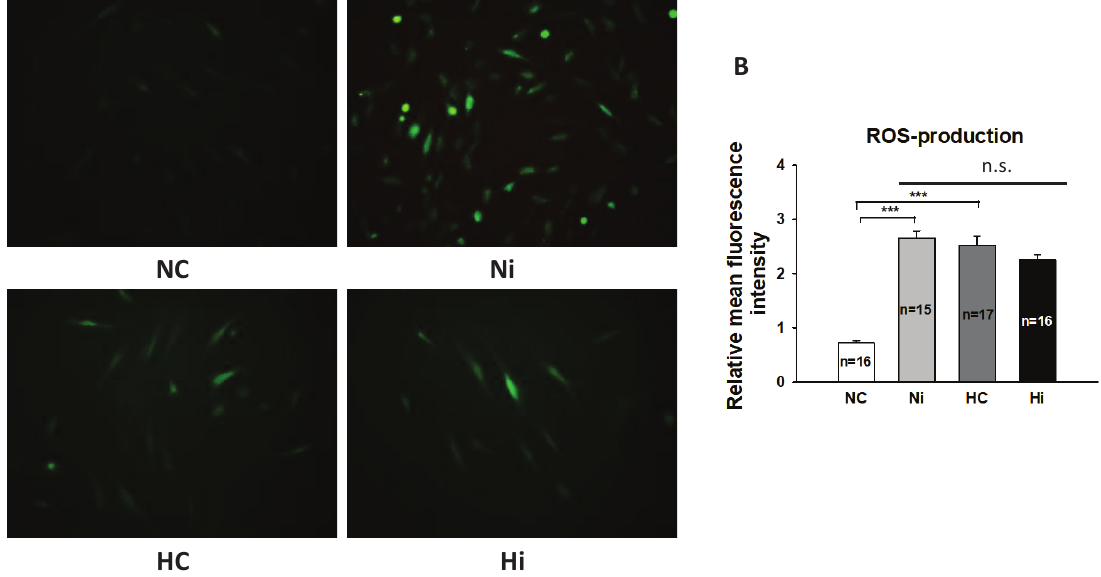
Figure 4. High-concentration isoprenaline and a high level of glucose induced ROS generation in hiPSC-CMs. Cells were incubated with 5 μ M DCFH-DA solution in serum-free medium at 37 °C for 30 min in the dark in each cell group. A fluorescence microscope was used to evaluate the fluorescence intensity of cells. “NC” represents data from hiPSC-CMs treated with normal level of glucose. “Ni” represents data from hiPSC-CMs treated with normal level of glucose and a high concentration of Iso. “HC” represents data from hiPSC-CMs treated with a high level of glucose. “Hi” represents data from hiPSC-CMs treated with a high level of glucose and a high concentration of Iso. ( A ) Representative pictures showing the fluorescence intensity of cells in different groups. ( B ) Statistical analyses of fluorescence intensity representing levels of ROS. Magnification, ×400. Data are presented as mean ± SEM and analyzed by one-way ANOVA with Holm–Sidak post-test. The cell number of every experimental group is given as “n”. *** p < 0.001. “n.s.” means no significance.